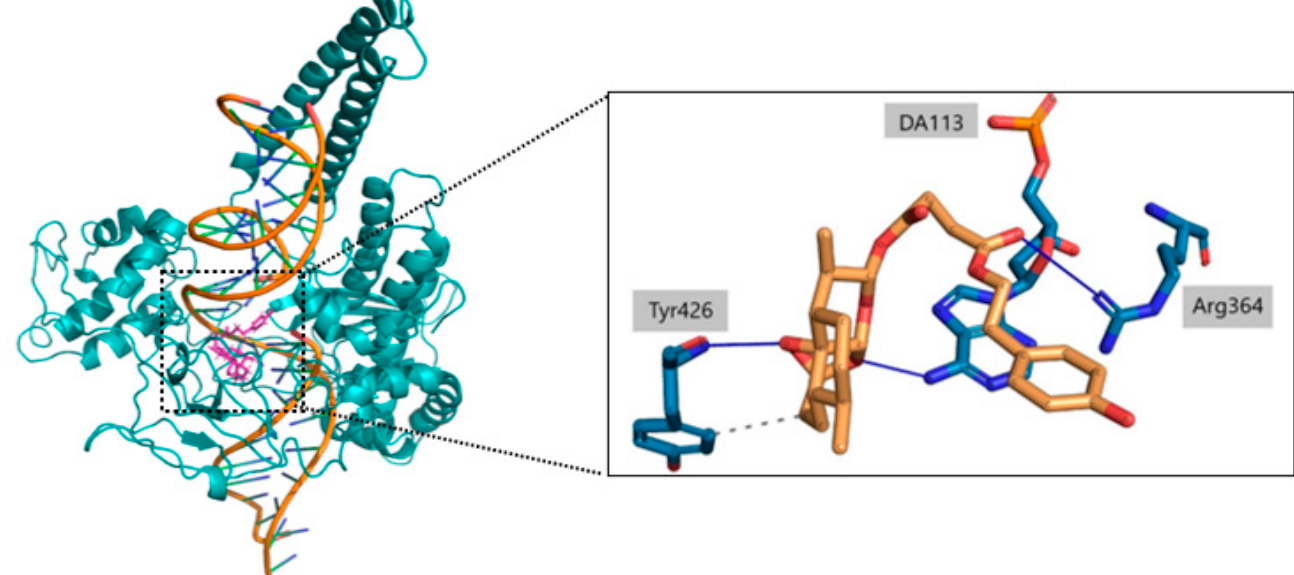
Figure 10. Right: 3D structures of compound c6 housed within the receptor pocket. Left: Highlighted are the atoms most involved in the formation of noncovalent interactions (hbonds in blue, hydrophobic bonds with dashed line) with the amino acids and nucleotides of the 1T8I receptor (belonging to the core-subdomain I portion of the protein and with the DNA double helix).